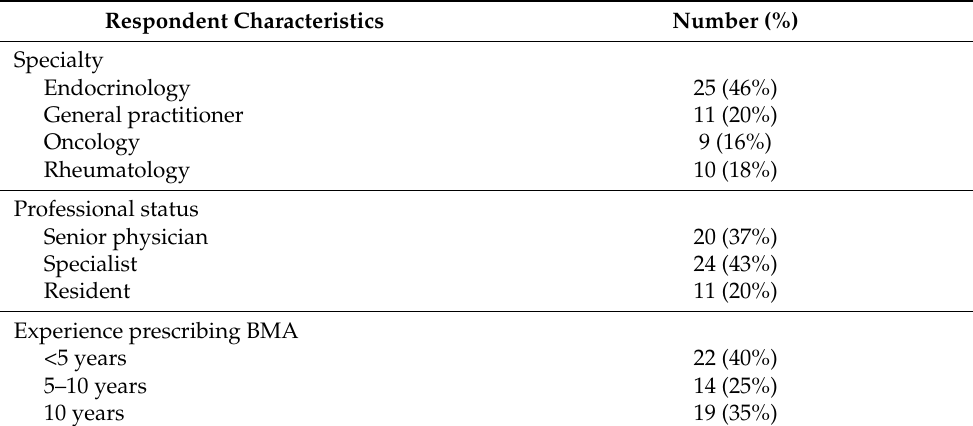
Table 3. Survey respondents’